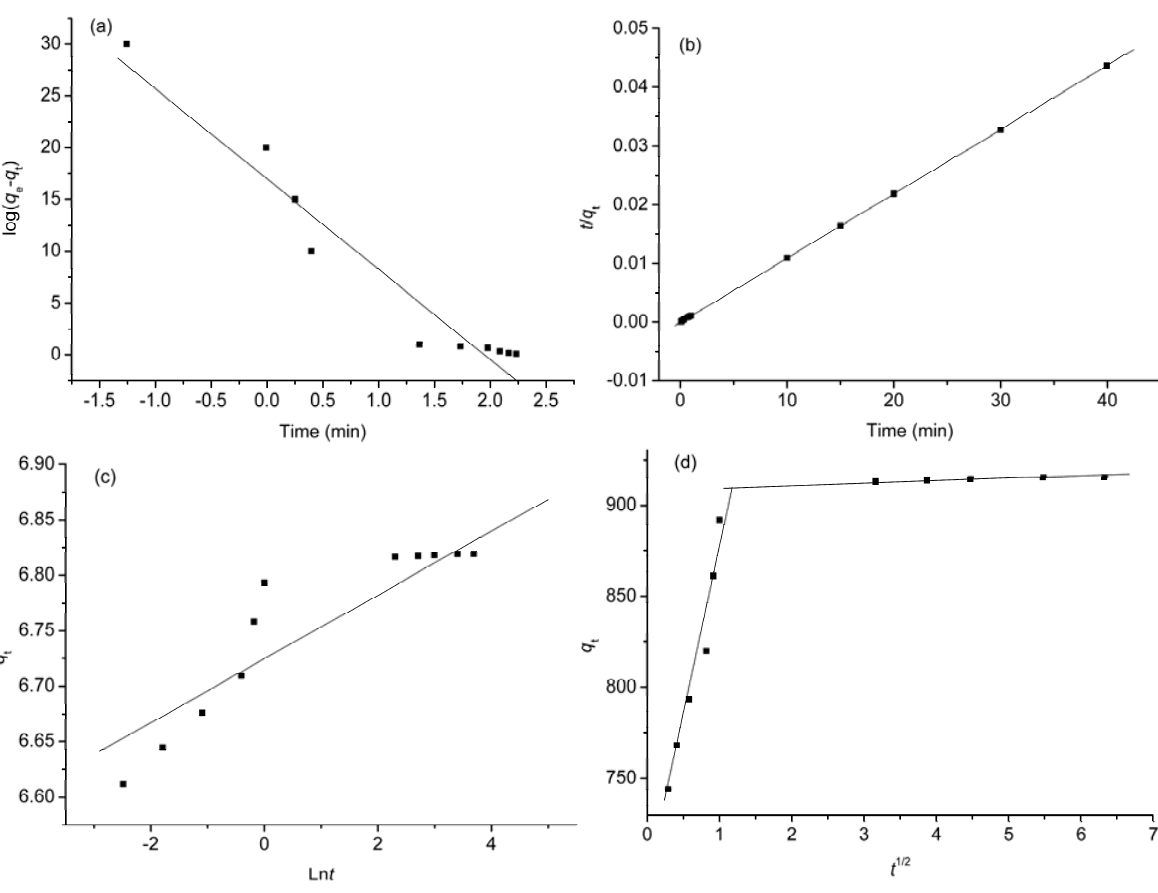
Figure 5. Adsorption kinetics of DOX adsorbed by GO: ( a ) pseudo- fi rst-order; ( b ) pseudo-second-order; ( c ) Elovich; and ( d ) intraparticle diffusion models.